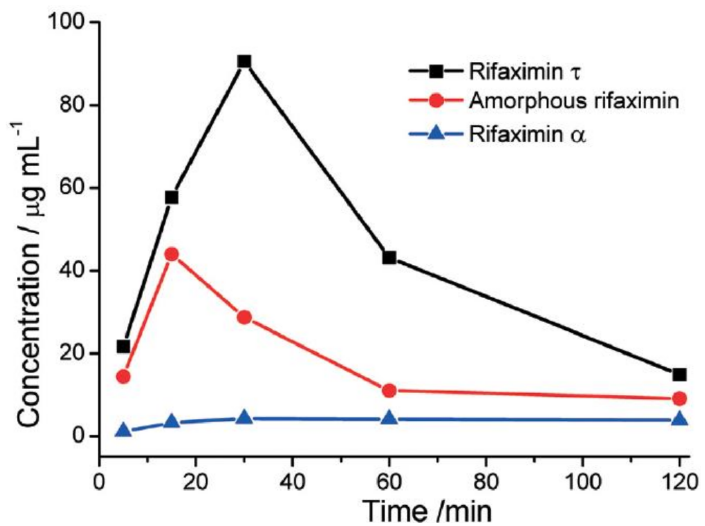
Figure 21. Comparison of dissolution rates for Rifaximin τ , amorphous Rifaximin, and Rifaximin α at neutral pH. Reprinted with permission from Ref. [67]. 2019, Royal Society of Chemistry.